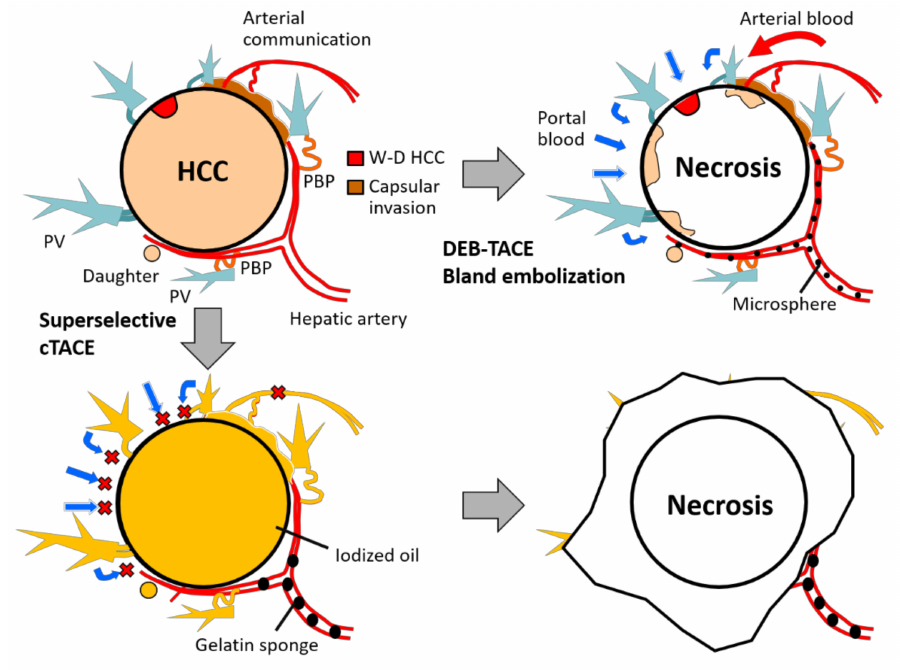
Figure 3. Schematic representation of rationale for superselective cTACE and DEB-TACE / bland embolization. Reproduced with permission from Ref. [33]. An Open Access article (CC BY 4.0). Abbreviations: W-D, well-di ff erentiated; PBP, peribiliary vascular plexus, PV, portal